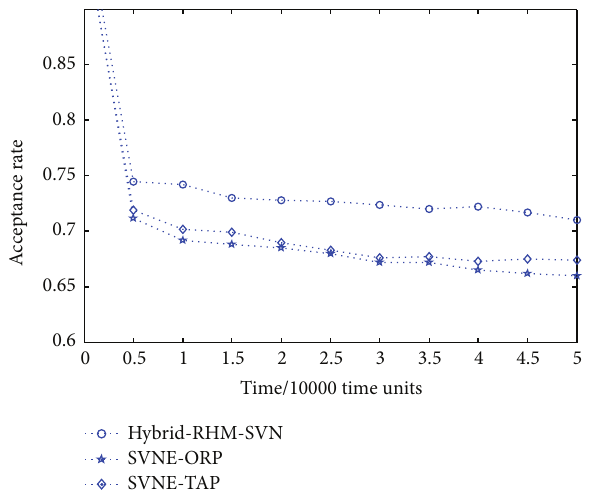
Figure 2: Average revenue of mapping virtual networks.